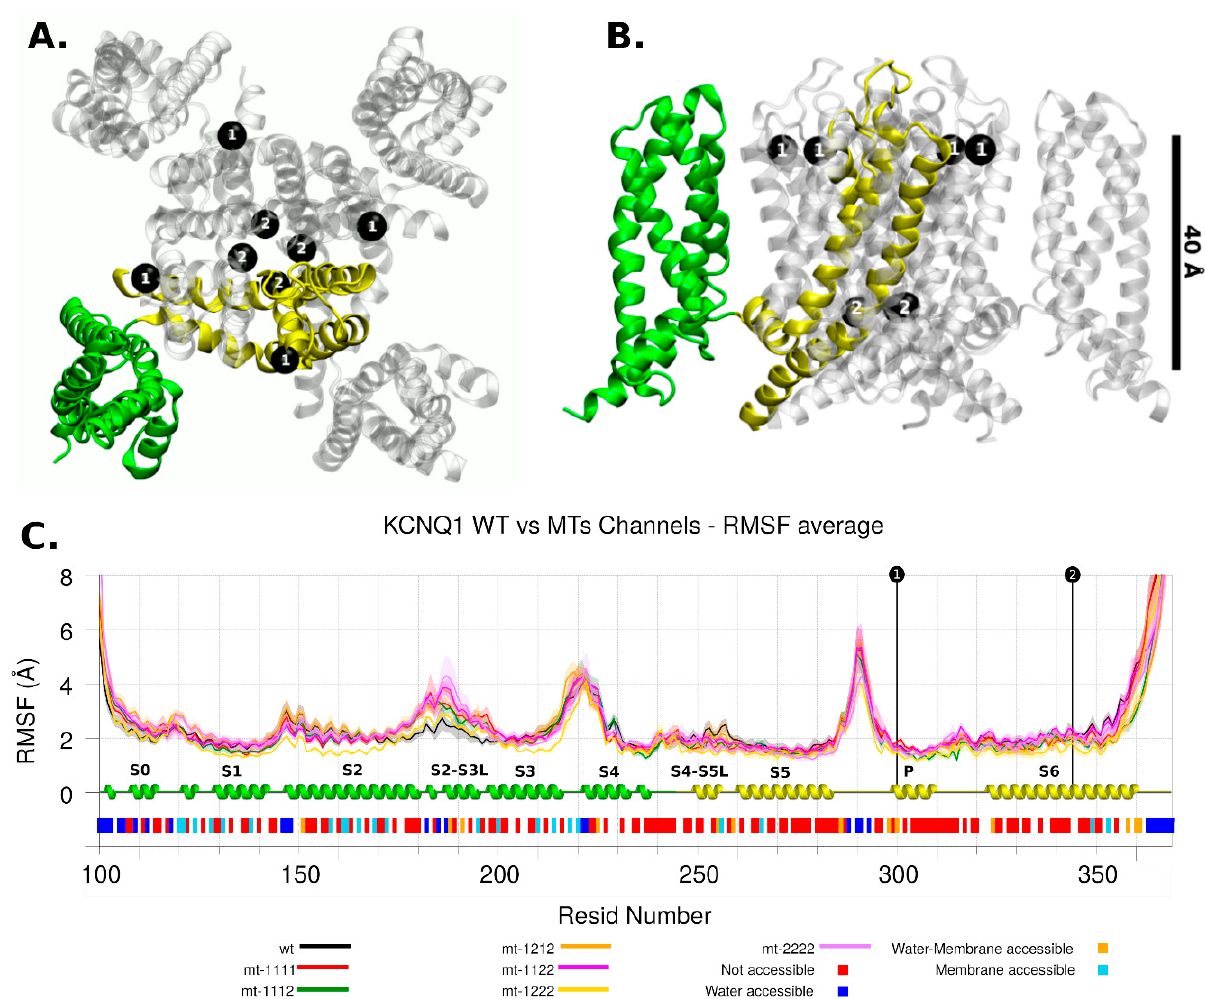
Figure 3. KCNQ1 Channel. The mutation location is shown with black dots and number 1 or 2. Two protein intermembrane domains are shown in green and yellow. ( A ) Top view. ( B ) Lateral view. ( C ) RMSF analysis for wild and mutant types. Each series corresponds to 4 chains and 4 replicas for each one, then it shows its average and standard deviation. The secondary structure motifs and solvent accessibility are shown below.